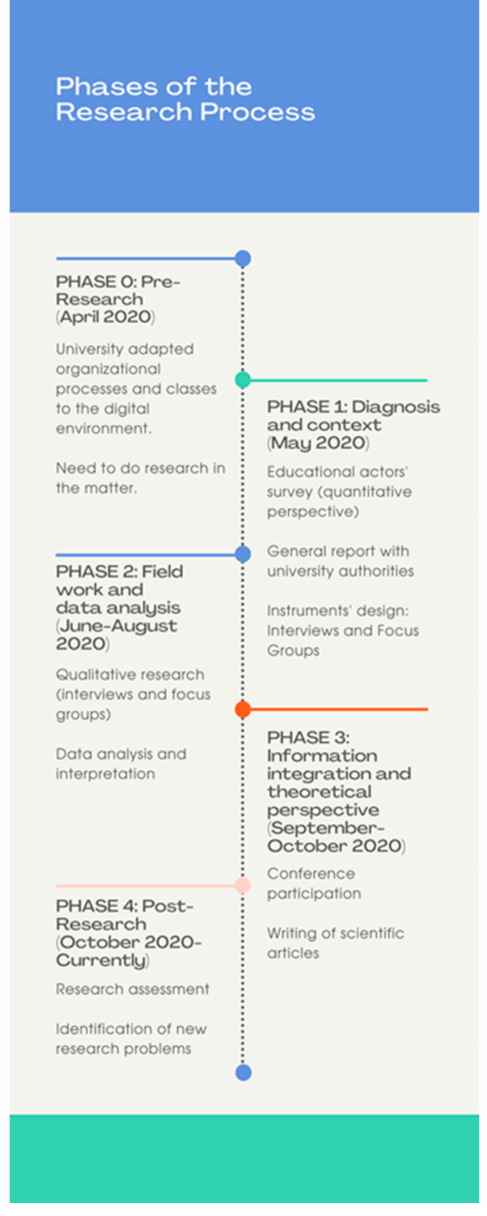
Figure 1. Research